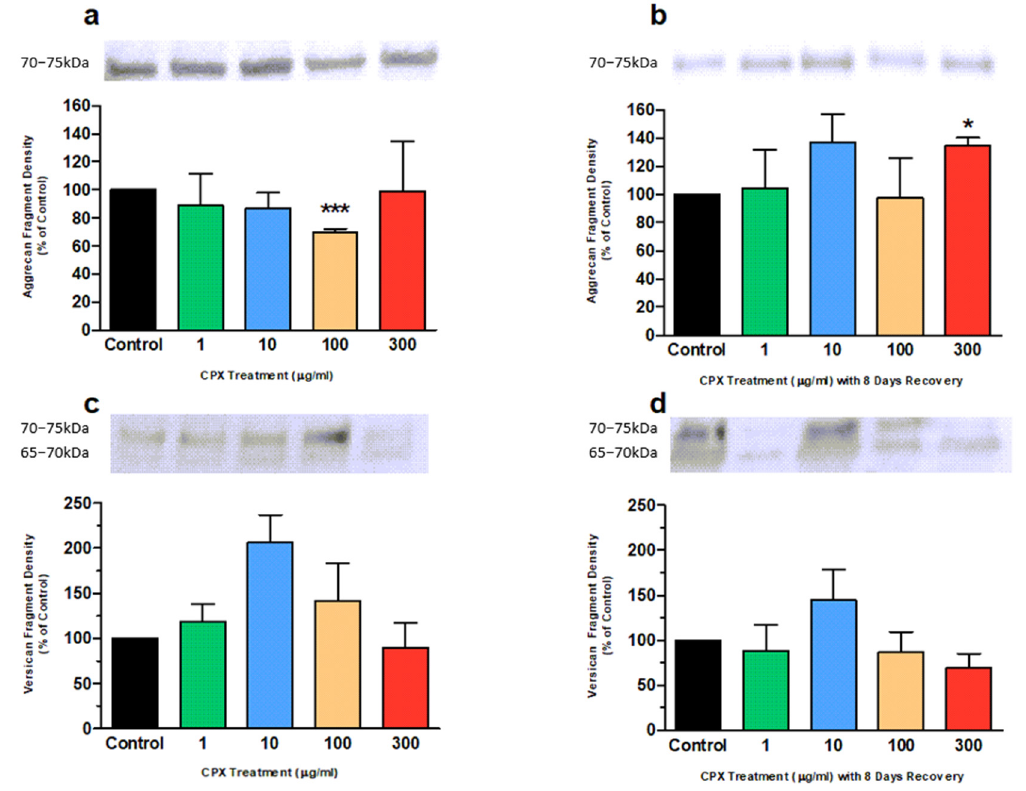
Figure 2. Densitometric analysis of the results of immunoblotting obtained from equine derived tendon explants after a 4 day culture period ( a , c ) and subsequent 8-day culture period without CPX treatment ( b , d ) with various concentrations of CPX as indicated. A monoclonal antibody (BC-3) against N-terminal interglobular domain neoepitope ARGVIL was used for detection of aggrecan fragments ( a , b ; n = 5) and a polyclonal antibody (VCAN) against N-terminal neoepitope DPEAAE was used for detection of versican fragments ( c , d ; n = 6). Values represent mean ± SEM and are expressed as % of control. * p < 0.05, *** p < 0.001 vs. control.